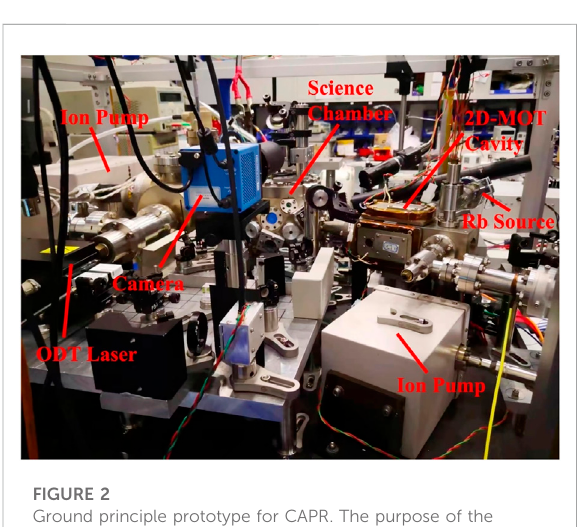
Remote control module; 5) Rack support module. As shown in Our ground-based veri fi cation system for CAPR is a Rb quantum gas system for physical experiments in space microgravity. In order to achieve the goal of miniaturization and low power consumption in the space station, there are several key techniques in the process of preparing Bose-Einstein condensation. High frequency laser phase lock technology is used to produce a tunable frequency-stabilized laser to cool atoms. The tuning range is ±12 GHz (dynamic range 500 MHz). Optical phase lock loop (OPLL) avoids the larger